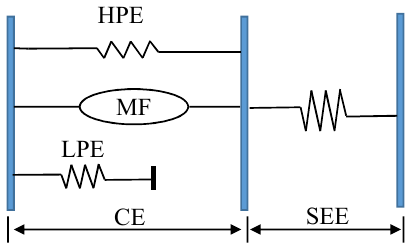
Figure 2. The virtual muscle mechanical